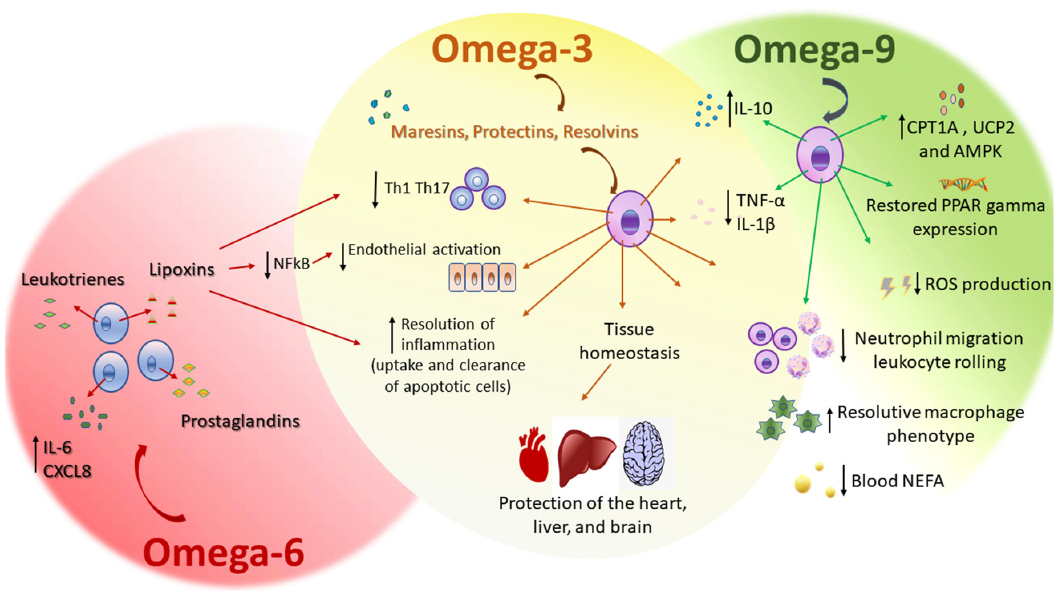
Figure 2. E ff ects of omega-6, omega-3, and omega-9 on inflammation in host cells.